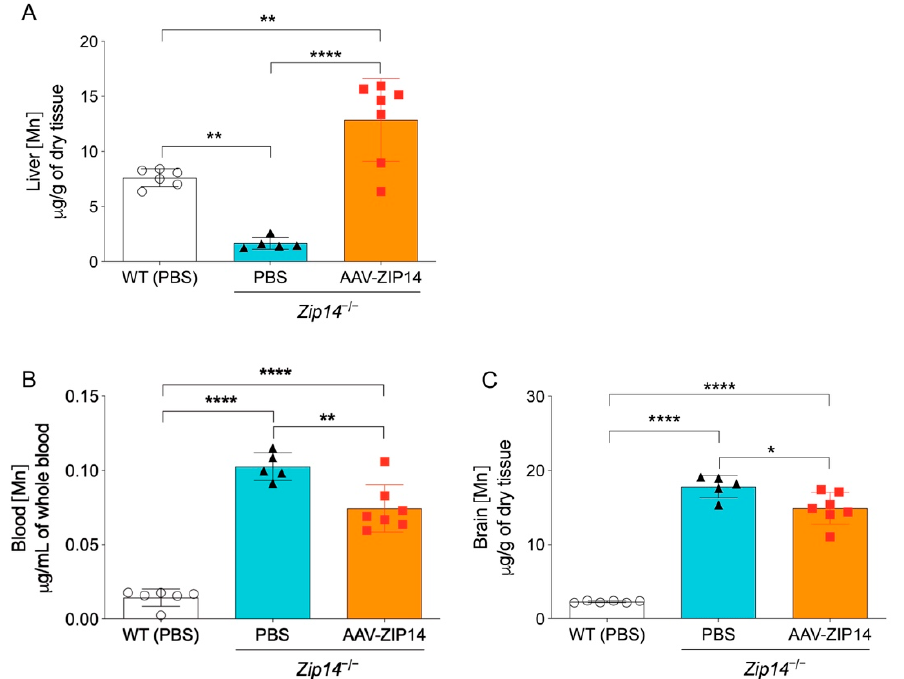
Figure 5. Restoration of hepatic ZIP14 expression increased liver manganese levels, but did not prevent brain manganese accumulation. ( A ) Liver, ( B ) blood and ( C ) brain manganese concentrations in PBS-injected WT and Zip14 − / − mice and AAV-ZIP14 injected Zip14 − / − mice were determined by ICP-MS ( n = 5 – 7 female mice/group). Data were expressed as mean ± S.D. and statistical analysis was performed using one-way ANOVA, followed by the Bonferroni post-hoc test. * p < 0.05; ** p < 0.01 and **** p < 0.0001.